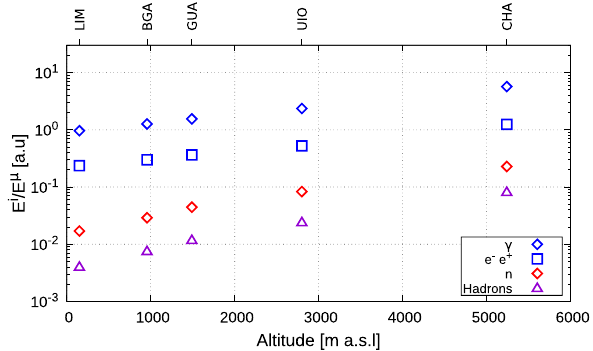
Fig. 7 The component-to-muon ratio, i.e., the ratio between the depositedenergywithinthedetectorvolumebyaparticularshowercom- ponent (photons, blue diamonds; electrons, blue squares; neutrons, red diamonds;andhadrons,violettriangles)dividedbytheenergydeposited bymuons,isshownforfiveLAGOsiteswithsimilargeomagneticrigid- itybutincreasingaltitudeatLima,Bucaramanga,Guatemala,Quitoand Chacaltaya. The observed trend for this ratio reflects the expected evo- lution of the cascades with altitude, as the impact of the atmospheric absorption is much lower for muons than for other shower components. High altitude sites are optimal for studying photon-initiated showers, such as those produced by